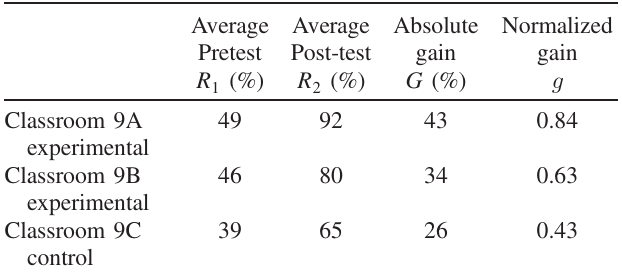
TABLE V. Classroom average classification, absolute gain, and normalized